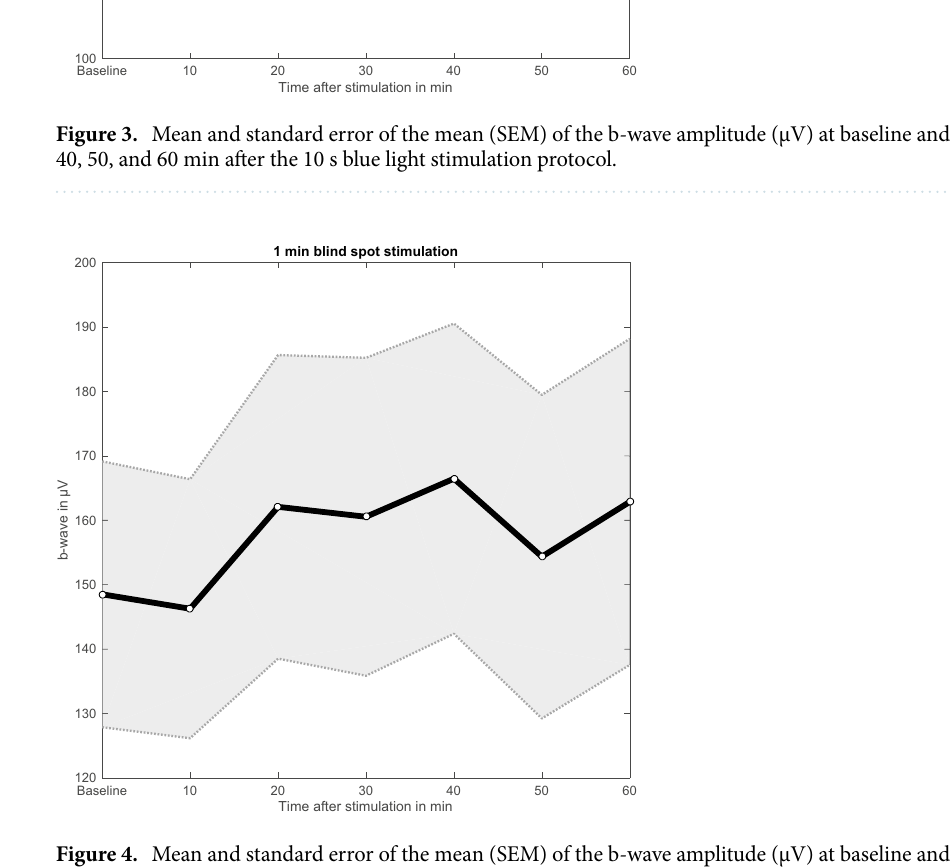
Figure 4. Mean and standard error of the mean (SEM) of the b-wave amplitude (µV) at baseline and 10, 20, 30, 40, 50, and 60 min after the 1 min blue light stimulation